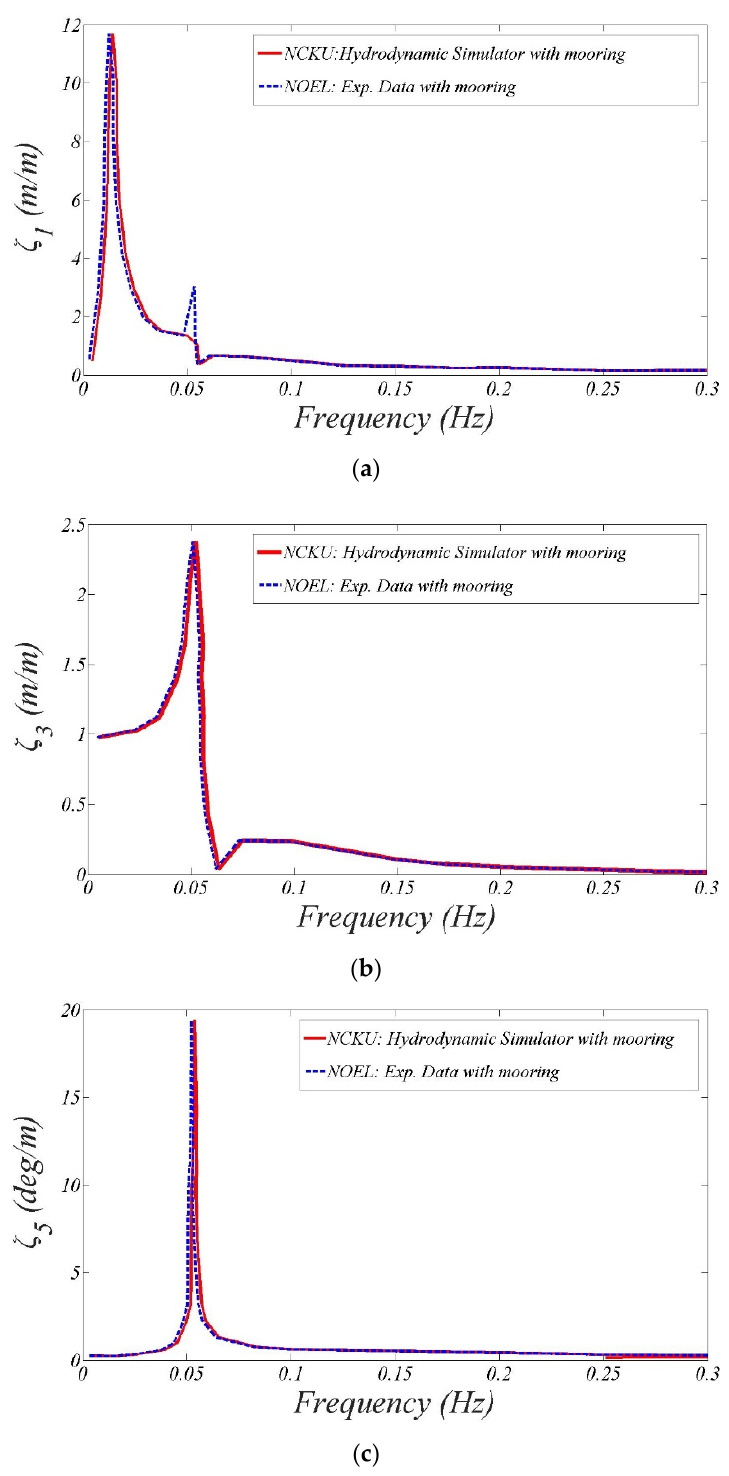
Figure 17. The performance of ( a ) surge, ( b ) heave, and ( c ) pitch RAOs as a function of wave frequency for the UMaine-Hywind spar by comparing hydrodynamic simulator with experimental data of NOEL.